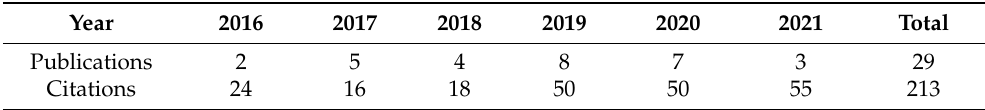
Table 10. Publication and citation counts based on the analysis pattern: TS = ((wind) AND energy security educ*). Source: Web of Science database.